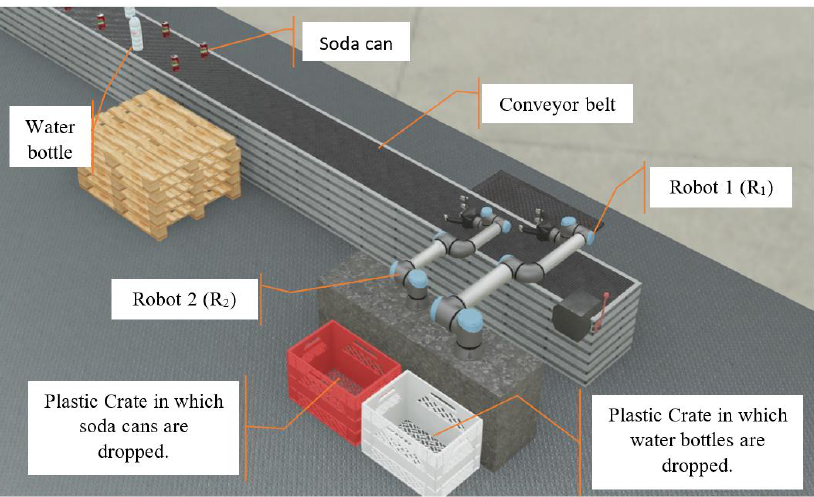
Figure 2. Robotic workspace.